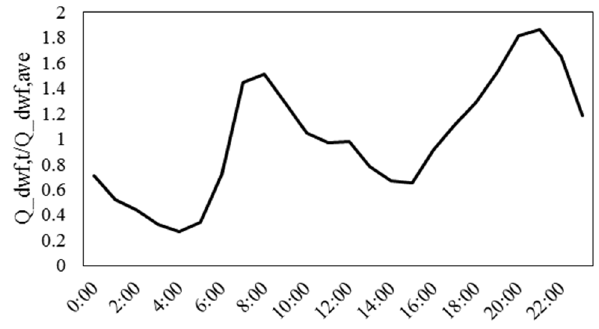
Figure 5. Flow variation line on typical dry